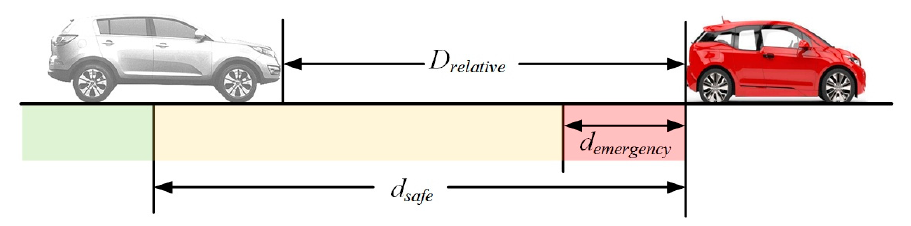
Figure 8. The relative distance division in the process of car-following. Based on the above analysis, when the actual relative distance between two vehicles is in the green part, the driving safety is the best. When the actual relative distance be- tween two vehicles is in the red part, the driving safety is the worst and there will be a collision. Therefore, d safe and d emergency are selected as the high-gain and low-gain boundaries of the sigmoid function. At the same time, by considering driving safety, we further cal- culate the mean value of d safe and d emergency with general drivers, including a male driving type and a female driving type. Combined with Equation (6), the value of A 1 and B 1 can be calculated and the membership function for safety indicator ( f(w) s ) will be represented as Equation (8):